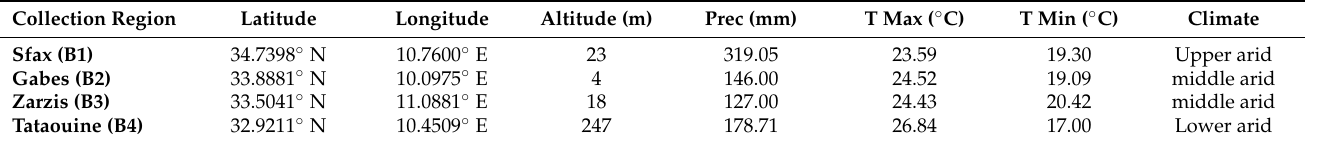
Table 5. Sampling sites and climate conditions (annual averages, 2015–2017, for each location) for four collection regions of Brassica tournefortii from south